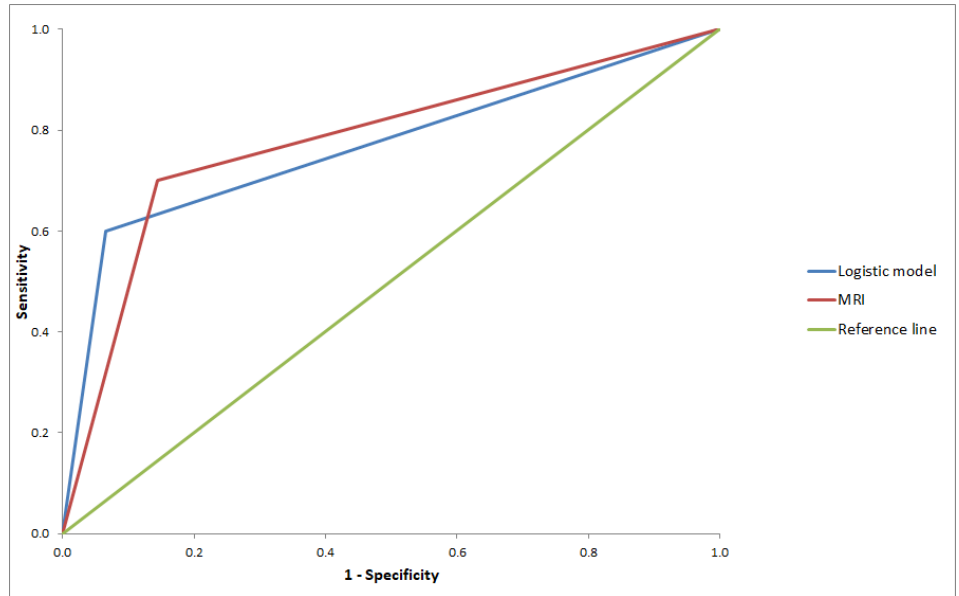
Figure 4. ROC curve describing the relation of sensitivity to specificity in clinical tests of the logistics model and MRI for the lateral meniscus.